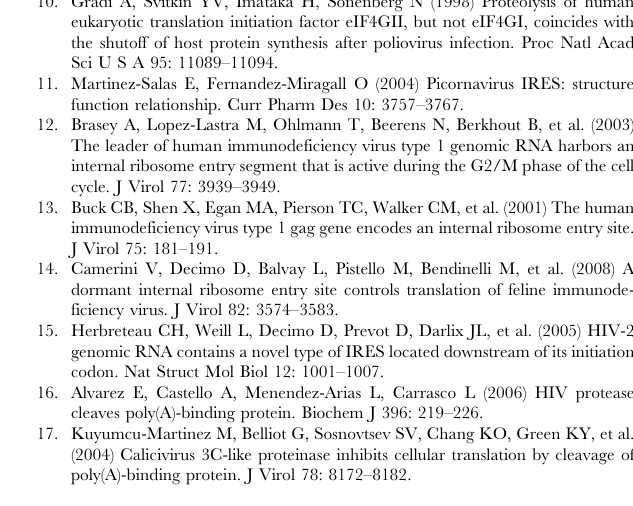
Figure S1 Translation of reporter luc mRNAs in HeLa extracts.